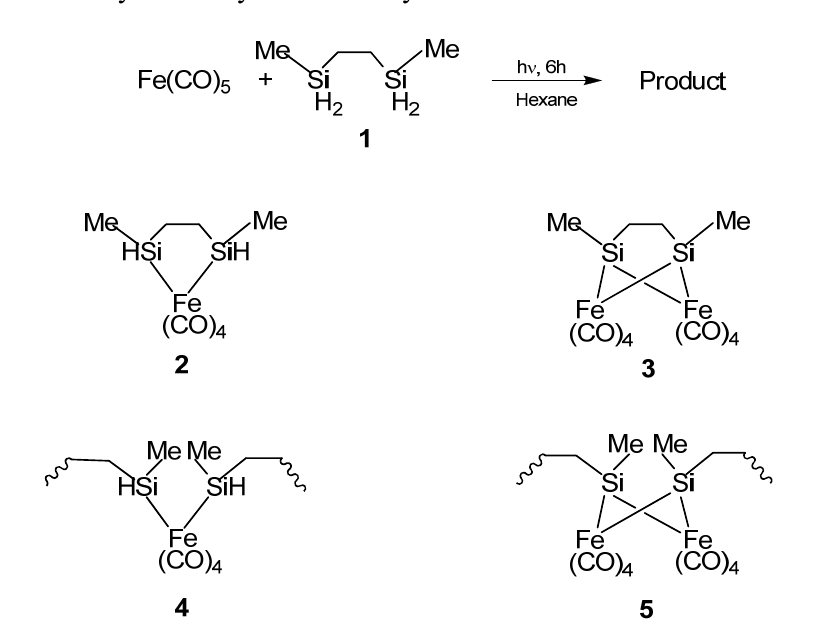
Figure 3. (Top) The reaction to form the organometallic product. (Bottom) The possible structures of the product formed from the reaction, with 2 and 4 being the probably formed ones based on elemental analysis and IR spectroscopy. From Ref. [62], Adapted by permission of The Royal Society of